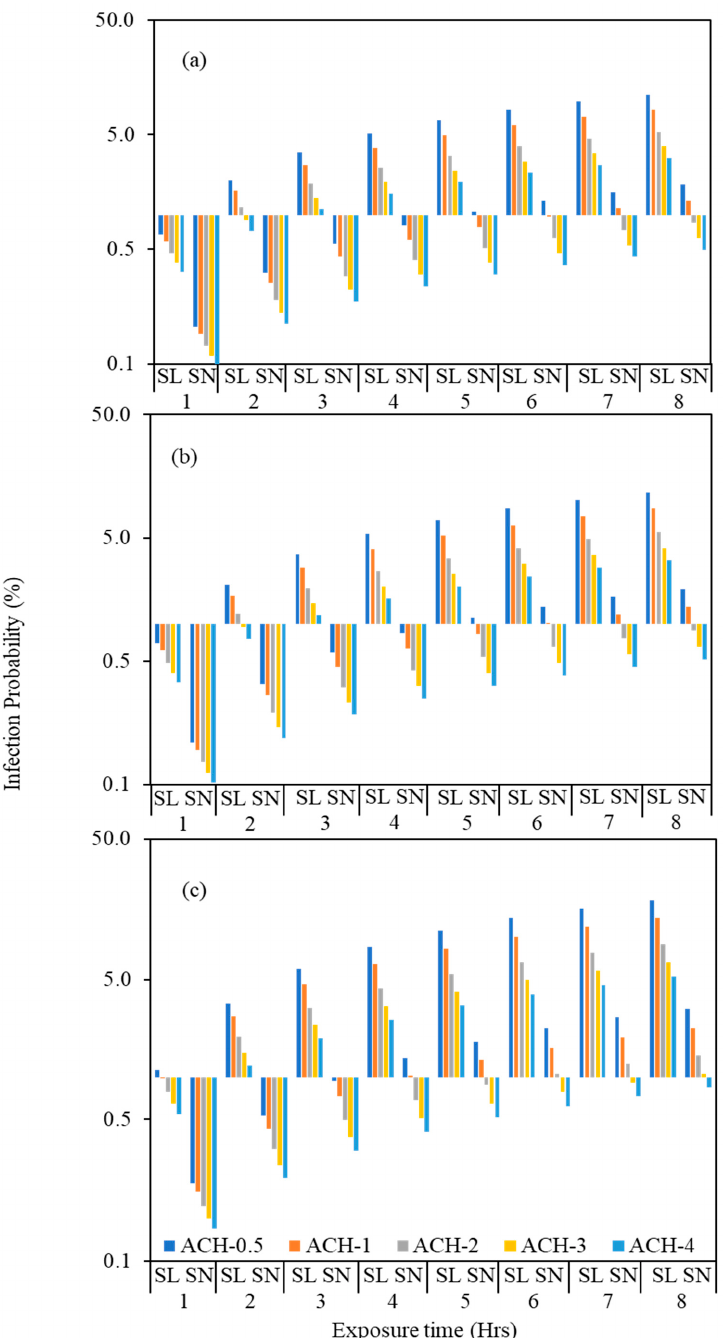
Figure 7. Probability of COVID-19 transmission (%) for the speaking loudly scenario (SL) and speaking normally (SN) by using the assumed five different ACH values such as 0.5, 1, 2, 3 and 4 to estimate the effect of ACH on the infection transmission for ( a ) HS5-OPR; ( b ) HS3-MDU and ( c )